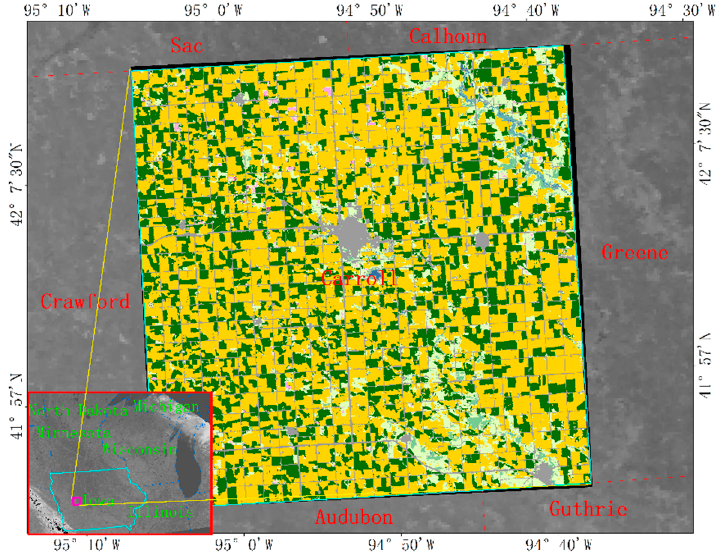
Figure 1. The study area (Carroll County) in the State of Iowa, U.S. The background grey map is daily MODIS NDVI image. The blue boundary in the small overview map overlaid at the lower left corner illustrates the State of Iowa. The color map overlaid in the middle is the NASS Cropland Data Layer (CDL) map of Carroll County. The dark green, yellow, and grey represent soybeans, corn, and development/open space categories. The light green and pink represent grass land and alfalfa.